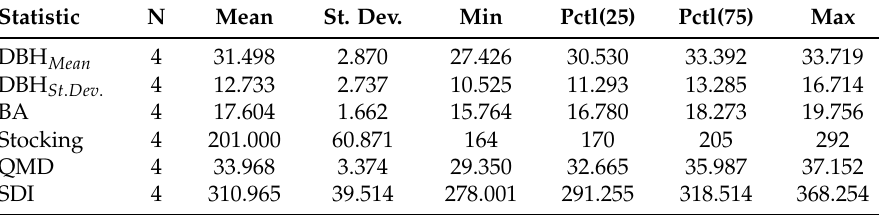
Table 3. JERC-RD forest inventory summary for the four tower plots in 2009; DBH = depth at breast height (cm); BA = basal area per hectare (m 2 ); Stocking = n trees per hectare; QMD = quadratic mean diameter (cm); SDI = Reineke’s stand density index